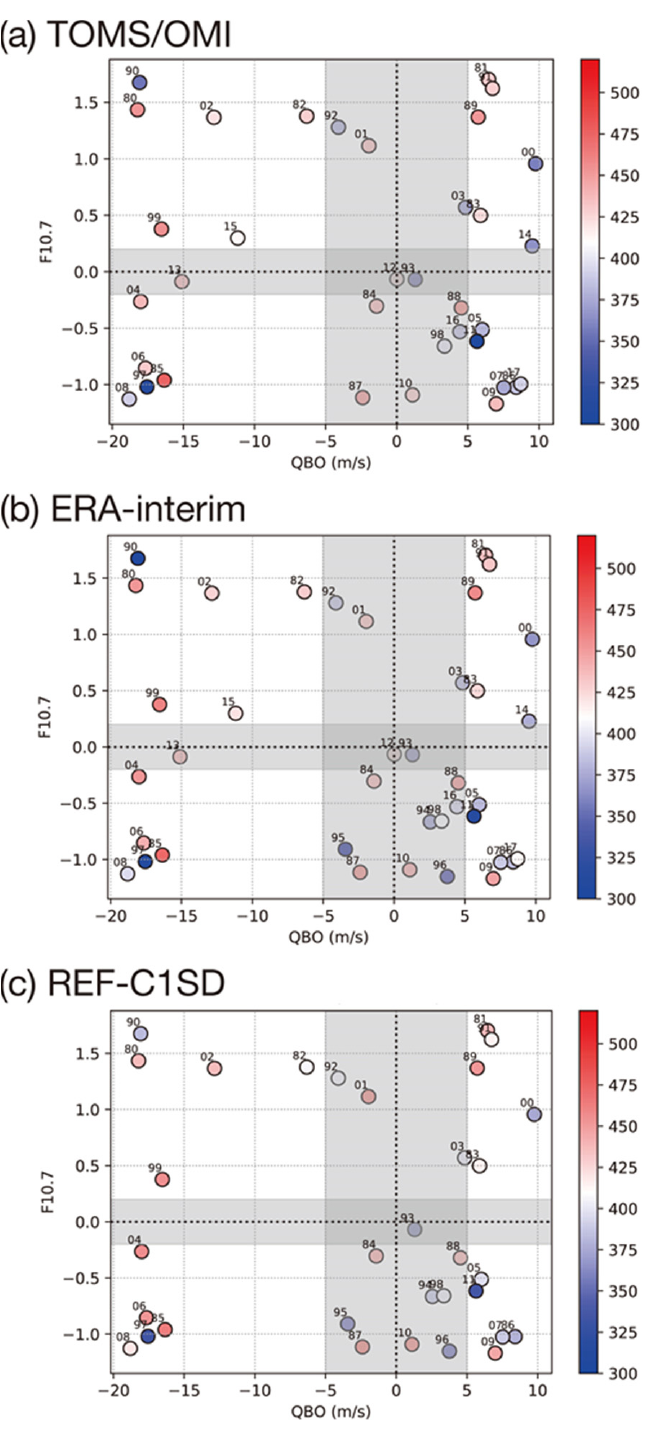
Figure 2. ( a ) Scatter plot between the QBO and F10.7 for the total ozone in March (color) averaged over the equivalent latitude from 70° N to 90 N for ( a ) TOMS/OMI observations, ( b ) ERA-Interim reanalysis data, and ( c ) REF-C1SD experiments. The average values of the TOMS/OMI observations, ERA-Interim reanalysis data, and REF-C1SD experiments are 410.1 DU, 408.4 DU, and 415.0 DU, respectively, which correspond to white on the color scale.